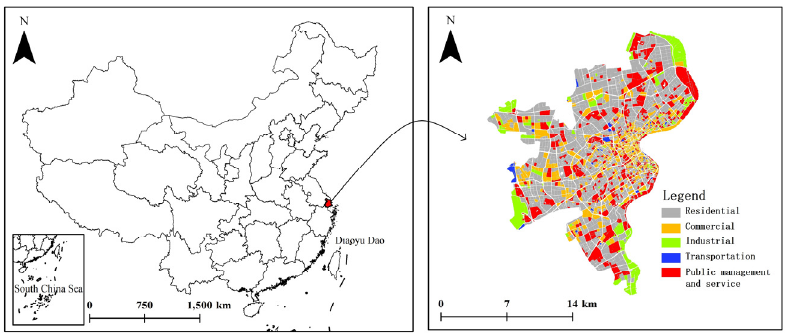
Figure 1. Location map of the study area.